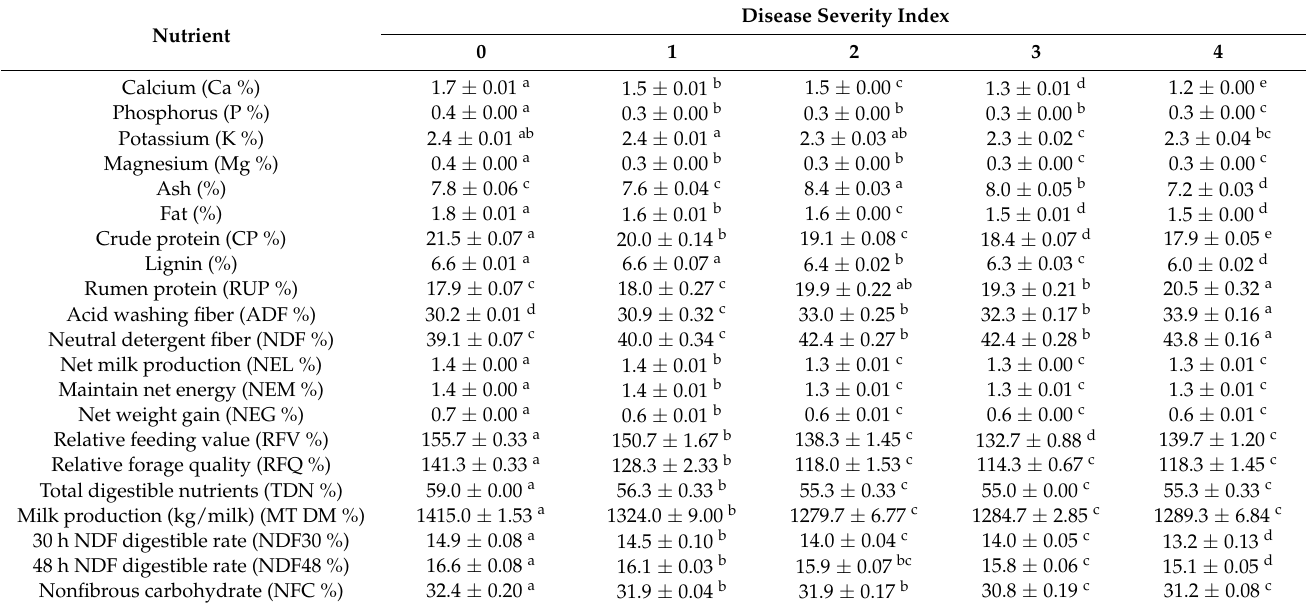
Table 3. Nutrients in alfalfa plants with different severity levels.